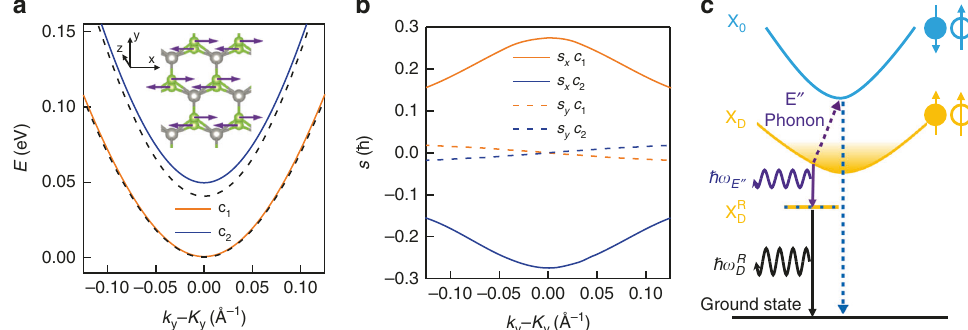
Fig. 4 Phonon coupling and recombination pathway of the K -valley dark-exciton. a The conduction band structure in the K valley, with the two Se atoms in one unit cell displaced by 0.035 and − 0.035 Å, respectively, calculated using Kohn − Sham density functional theory. The conduction band bottom is set to 0 eV. The k path is taken along the y direction across the K point, i.e., k x = K x . The lower ( c 1 ) and upper ( c 2 ) conduction bands are colored orange and blue, respectively. The black dashed lines are the two conduction bands in the equilibrium structure. Inset: a schematic of an E ″ phonon eigenmode. Gray and green spheres are W and Se atoms, respectively. Arrows indicate displacement. b Expectation values of conduction-band electron spin angular momentum in the x and y direction, S x (solid line) and S y (dashed line), of c 1 (orange) and c 2 (blue) as a function of k . c The bright exciton (X 0 ) band and dark exciton (X D ) band are denoted by the blue and yellow parabola, respectively. The solid circle and the empty circle represent the electron and the hole, respectively, while the arrows up and down indicate the spin orientation. The yellow-shaded area above X D indicates a quasi-equilibrium population of dark excitons at 4.2 K. The dark-exciton phonon replica ( X R ) state is labeled by a line with alternating blue and yellow color, indicating coupling between X 0 and X D by D emitting a chiral E ″ phonon of an energy ħ ω E ″ (purple wavy arrow). The photon emission by X R is labeled by the black arrow, having an energy (cid:1) h ω R . The D D emission process from X D , in the second-order perturbation theory, is illustrated by the purple wavy and blue dashed lines, corresponding to the emission of a chiral E ″ phonon and a circularly polarized photon, respectively. The intermediate state is the bright exciton X